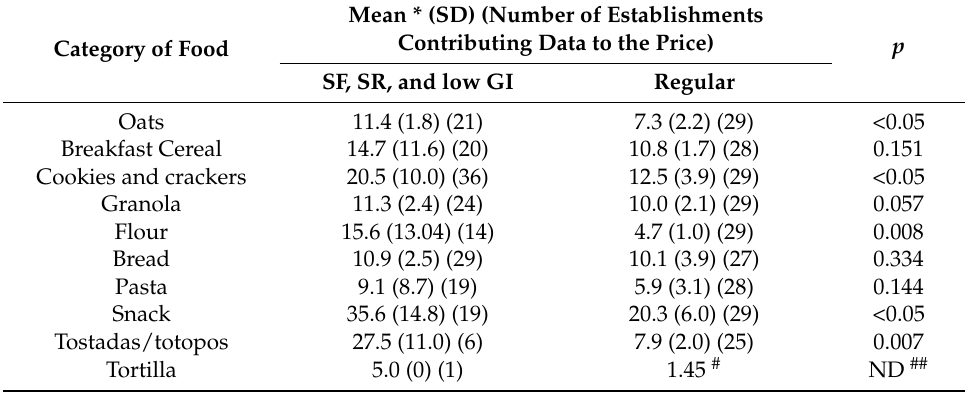
Table 1. Price comparison between cereal products labeled as SF, SR, or low GI and their regular counterparts. Mean * (SD) (Number of Establishments Contributing Data to the Price) p Category of Food SF, SR, and low GI Regular Oats 11.4 (1.8) (21) <0.05 14.7 (11.6)